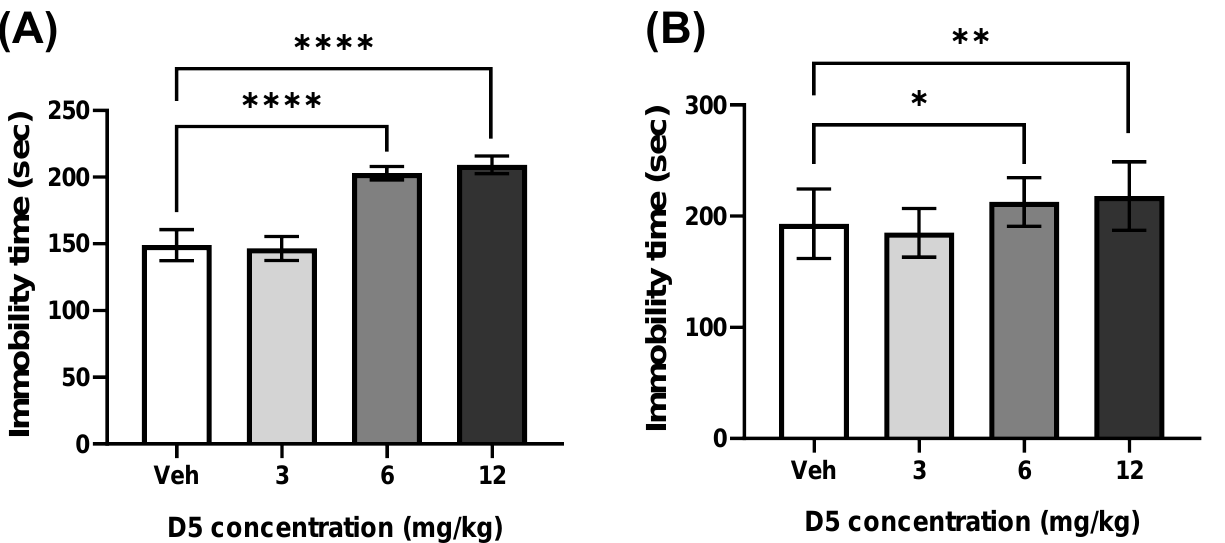
Figure 4. Effect of D5 exposure on depression in offspring mice: ( A ) bar graph of immobility time in the tail suspension test; ( B ) bar graph of the immobility time in the forced swimming test. The significance was obtained using an ANOVA test. * p < 0.05, ** p < 0.01 and **** p < 0.0001 vs. vehicle. Each value is expressed as the means ± SEM. Vehicle ( n = 20), D5 3 mg/kg/day ( n = 14), D5 6 mg/kg/day ( n = 33), and D5 12 mg/kg/day ( n = 30). Veh, vehicle.